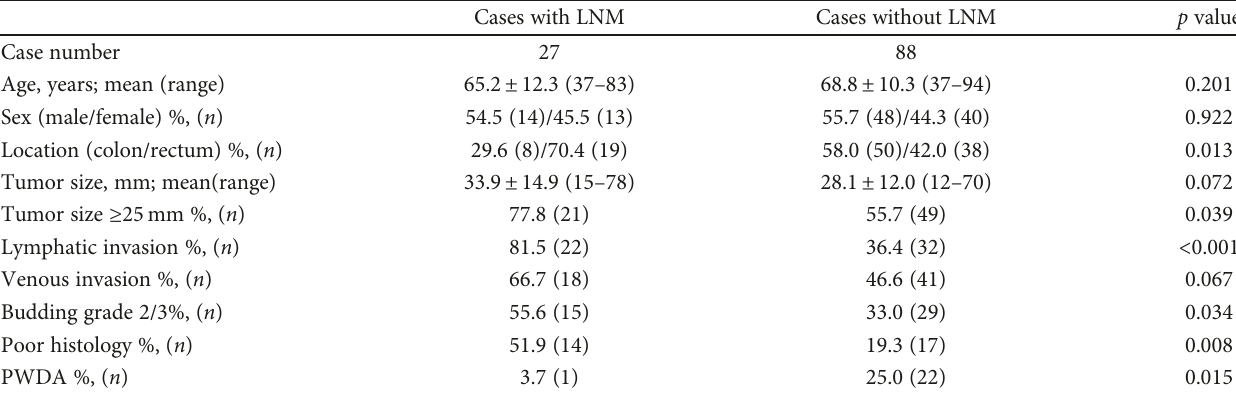
Table 2: The clinicopathological analysis between cases with and without LNM among T2 cancers.